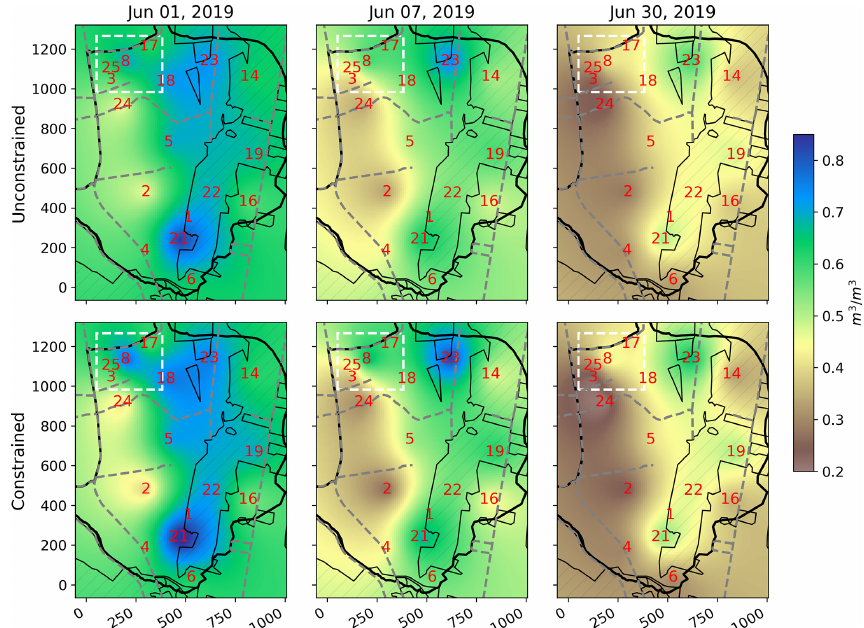
Figure 6. Daily average soil moisture on three different dates (left: 1 June, centre: 7 June, right: 30 June 2019) and for the uncon- strained/constrained interpolation model (top/bottom row). Also shown are locations and IDs of the CRNS sensors used for the interpolation (red), the catchment boundary (black line), forest (grey hatching with a black contour), roads (dashed grey line), and the extent of the SoilNet (dashed white rectangle). The figure uses OSM basemap layers for land use and roads (© OpenStreetMap contributors 2020; distributed